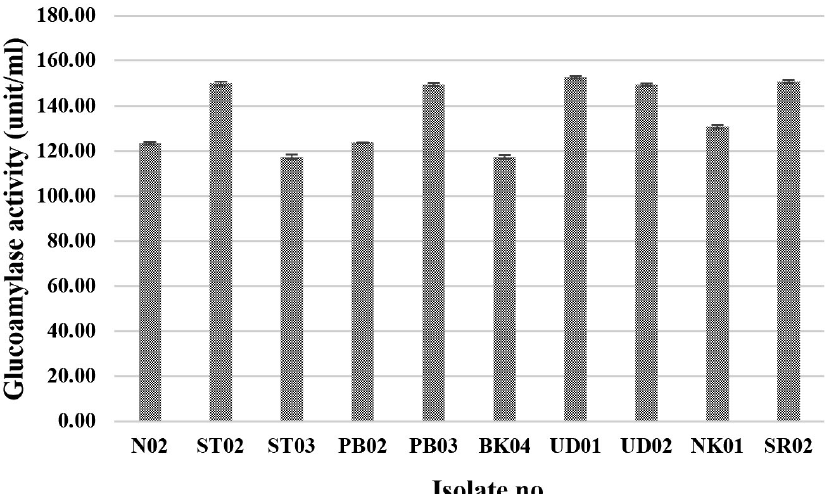
Fig.2.(B). Glucoamylase activities of fungi were isolated from Loog-pang-khao-mak ; (B) Glucoamylase activities of ten mold